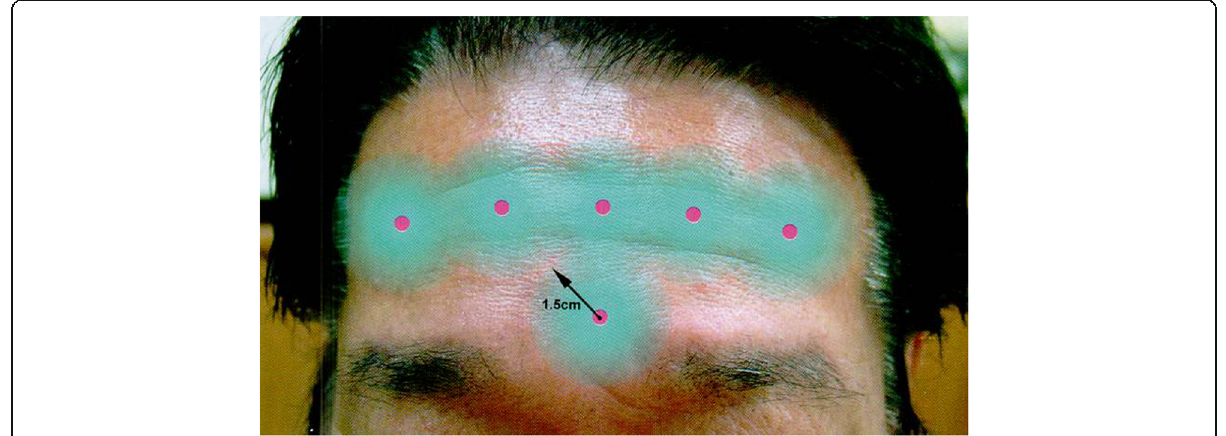
Fig. 5 When injecting botulinum toxin in the forehead wrinkles, noted that the injecting point should be 1.5 – 2 cm far away from the